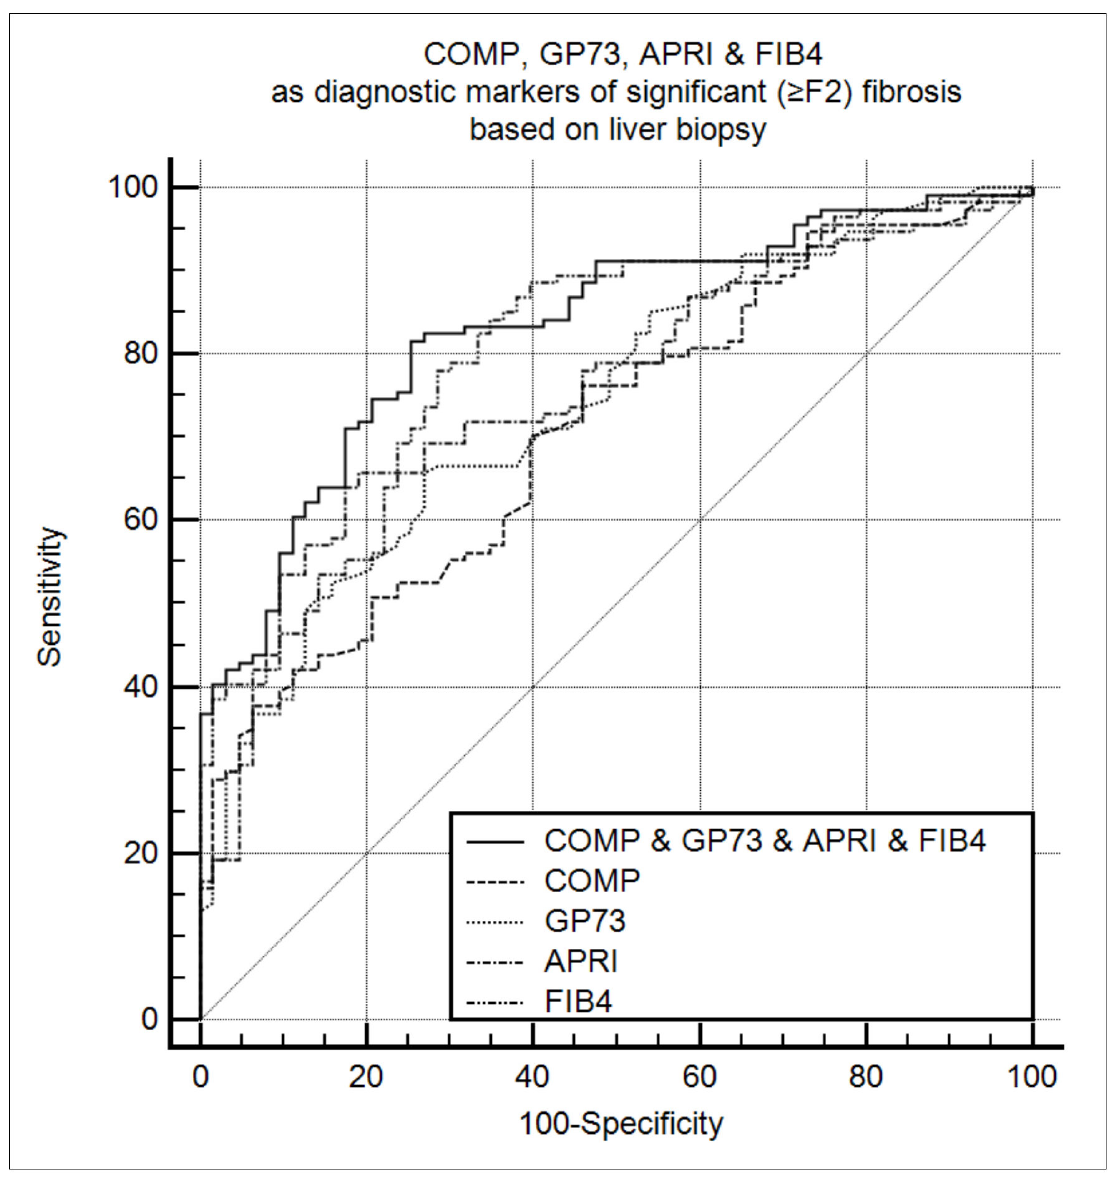
Figure 3. COMP, GP73, APRI, and FIB-4 as diagnostic markers of significant fibrosis ( ≥ F2) according to liver biopsy ( n = 177). The combination of COMP, GP73, APRI, and FIB-4 had the highest diagnostic performance [AUC (95% CI): 0.832 (0.768–0.883)] compared to each marker alone: GP73 [AUC (95% CI): 0.742 (0.671–0.804); P = 0.01], COMP [AUC (95% CI): 0.708 (0.635–0.774); P < 0.001], APRI [AUC (95% CI): 0.762 (0.692–0.822); P = 0.068], and FIB-4 [AUC (95% CI): 0.799 (0.732–0.865); P = 0.171]. COMP: Cartilage oligomeric matrix protein. GP73: Golgi protein 73. APRI: Aspartate aminotransferase to platelets index. FIB-4: Fibrosis-4. AUC: Area under the